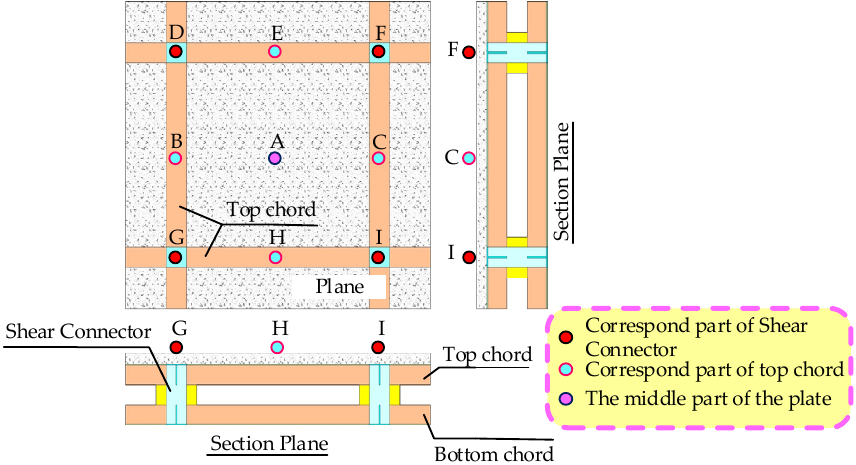
Figure 4. Schematic diagram of typical parts of floor.